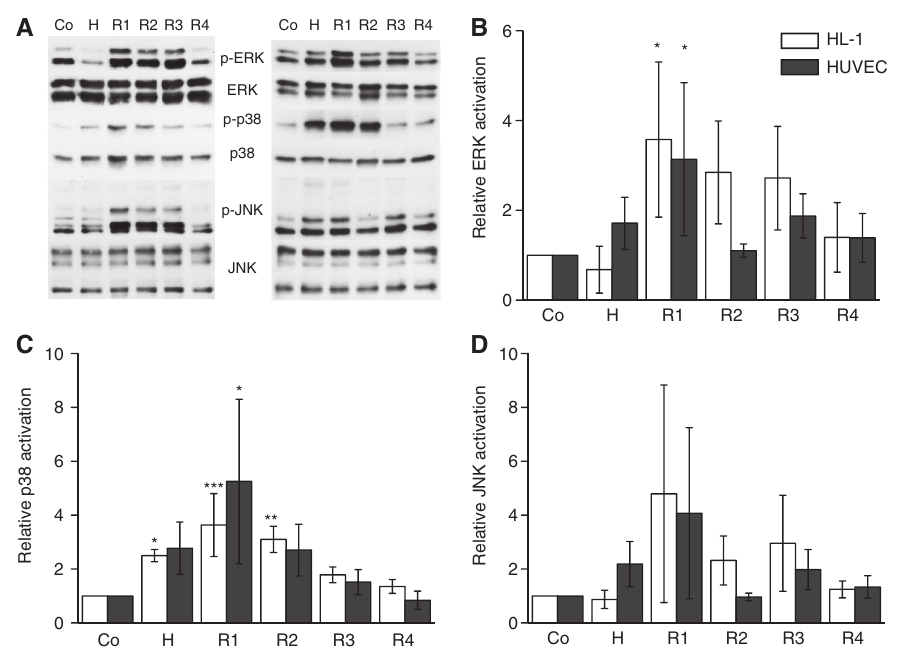
Figure 1 Alterations in MAPK activity during H/R in HL-1 cells and HUVECs. Cells were exposed to 45 min of hypoxia followed by reoxygen- ation. Immediately after hypoxia (H) and after 10 min (R1), 2 h (R2), 6 h (R3), and 24 h (R4) of reoxygenation, cells were harvested and MAPK activity was analyzed by Western blotting. Representative immunoblots are shown (A). (B–D) Summary bar graphs of ERK (B), p38 (C), and JNK (D) activation during H/R. Relative activation levels were calculated by normalizing phospho-MAPK signals to total MAPK levels; con- trols (Co) were set to 1.0. Data are expressed as mean ± SD (n = 3, *p < 0.05, **p < 0.01, ***p < 0.001 vs. control).